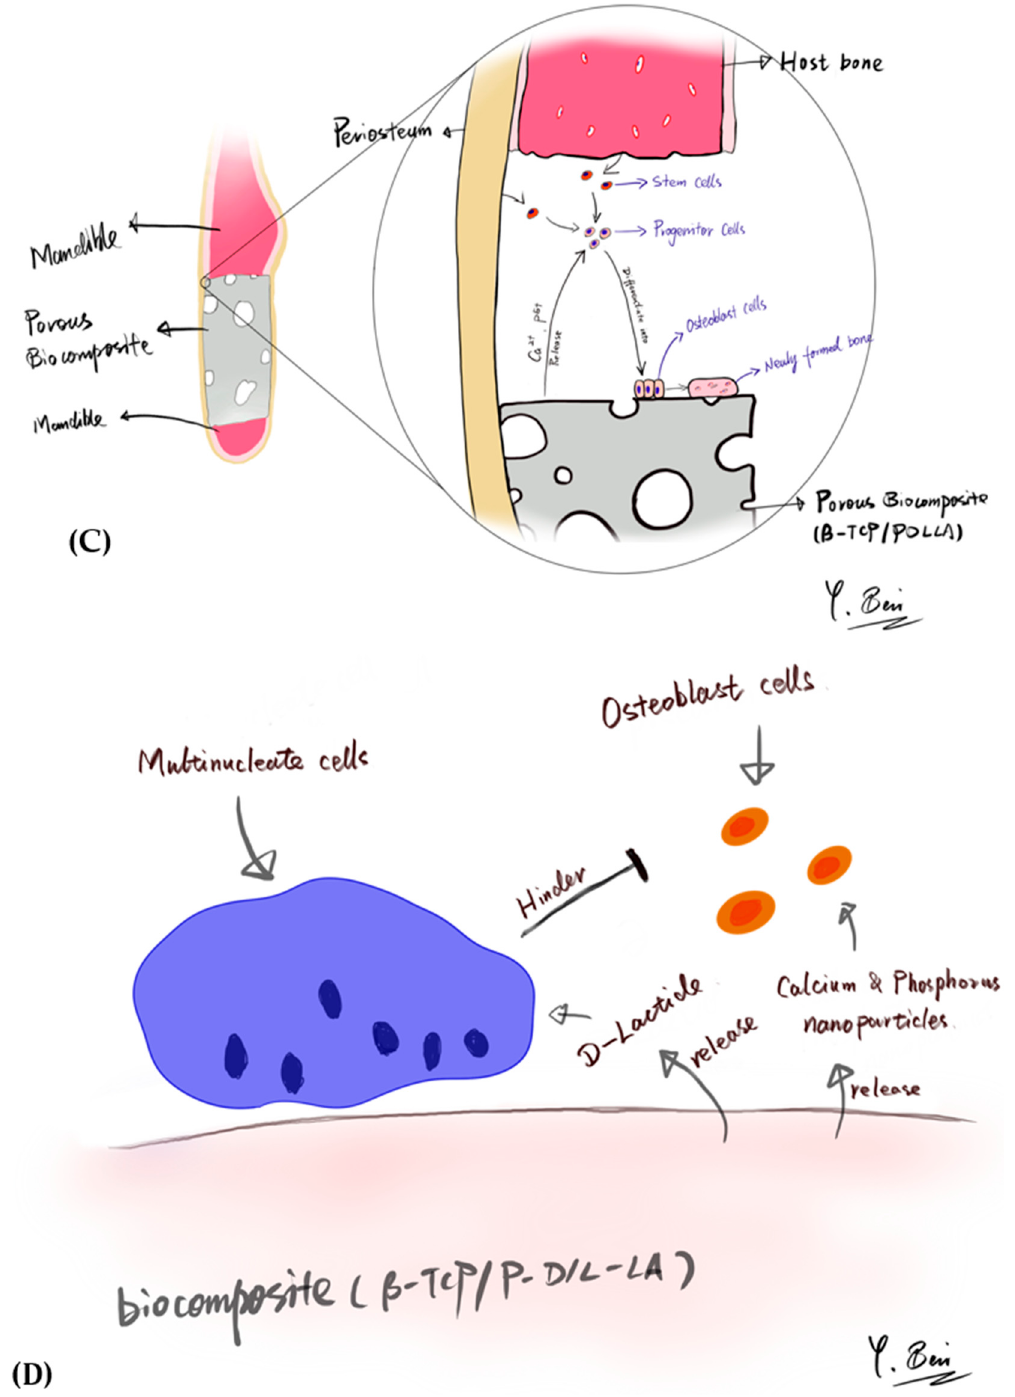
Figure 9. Multinucleate cells accumulated around the scattered β -TCP/PDLLA material at 2 weeks ( A ) and 4 weeks ( B ). Scale bars: 50 μ m. Black arrows indicate the multinucleate cells surrounding the scattered biocomposite. RM: residual material. ( C ) Overview of osteoblast matsuration and new bone formation. The stem cells predominantly derived from bone marrow and periosteum undergo a condensation process and form primitive progenitor cells. With the degradation of porous biocomposites, such as β -TCP/PDLLA, large amounts of Ca 2+ and P 5+ ions are released into the milieu, which is essential for further differentiation of progenitor cells into immature osteoblasts [52]. Finally, immature osteoblasts differentiate into mature and functional cuboidal cells that secrete bone matrix and form new bone. ( D ) The accumulated multinucleate cells may competitively occupy the scattered material surface with osteoblasts. Meanwhile, the released Ca 2+ and PO 43 − ions may also be blocked by this behavior, causing a delay or cessation of osteoblast differentiation [52,55].